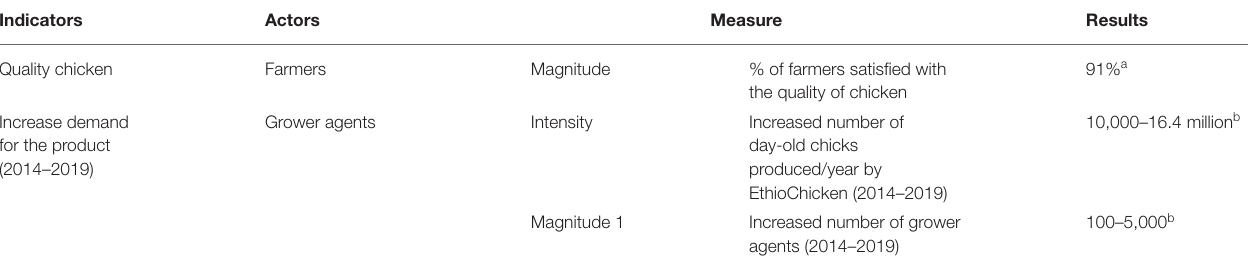
TABLE 4 | Indicators of impact on trust related to different stakeholders generated by the PPPs between the Ethiopian government and EthioChicken.